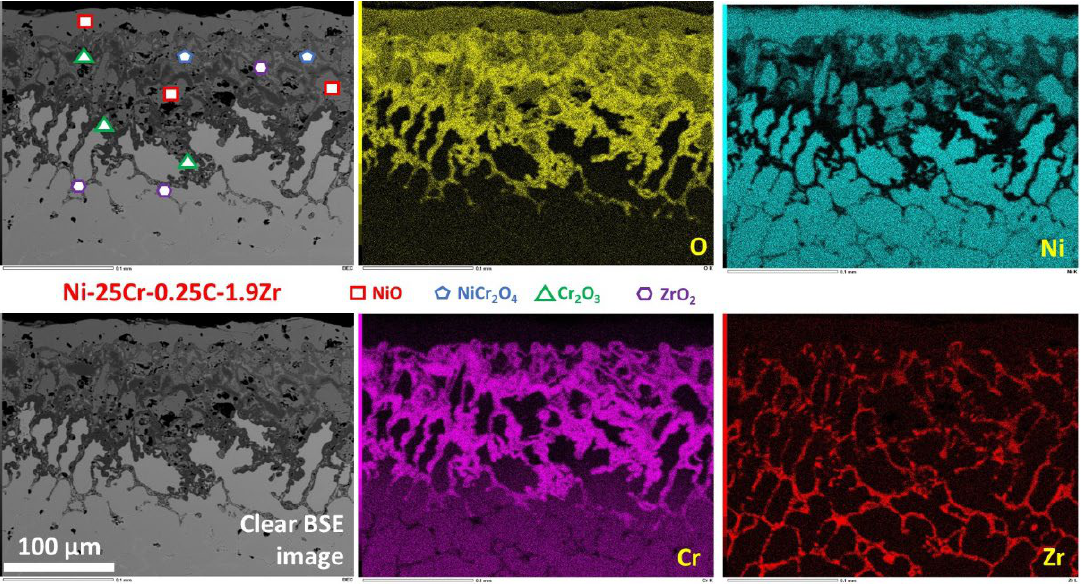
Figure 9. SEM/BSE micrographs (with and without oxide identification) with the elemental X-maps (oxide scale and oxidized subsurface of the Ni–25Cr–0.25C–1.9Zr alloy).